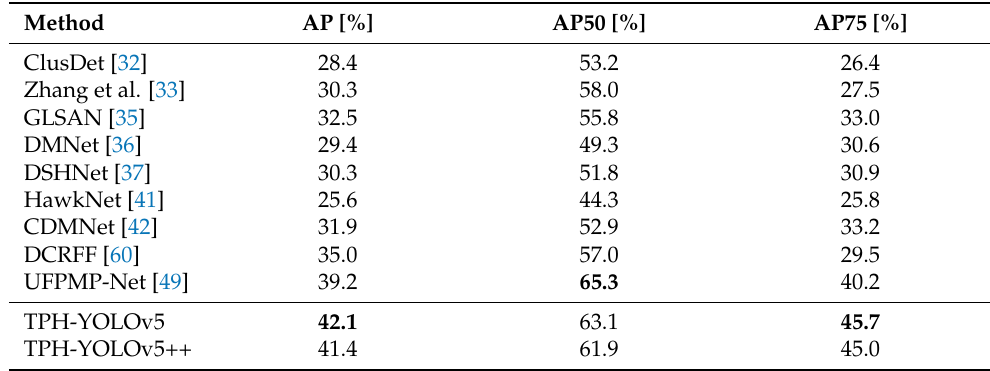
Table 2. Results of our methods and current SOTA methods on the VisDrone2021 validation